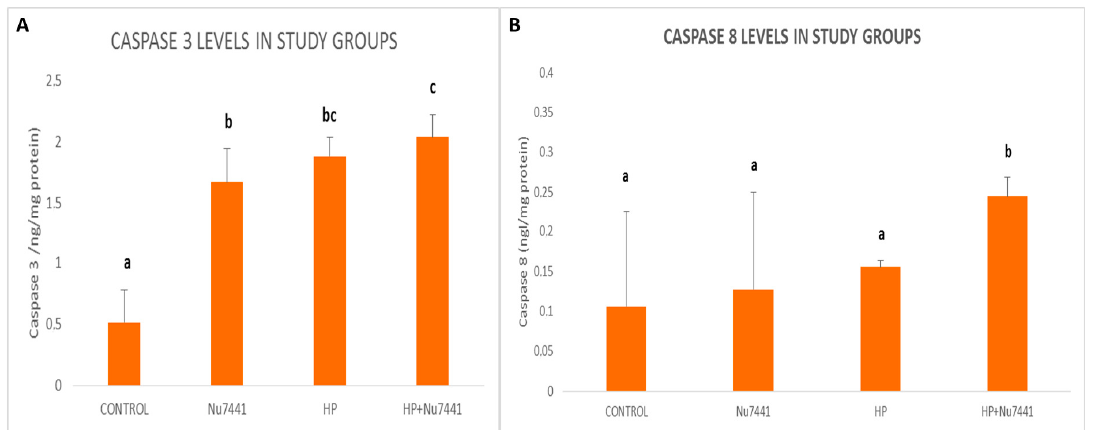
Figure 1. ( A ) Caspase-3 levels in the study groups. ( B ) Caspase-8 levels in the study groups. a,b,c Bars that do not have the same superscripts are significantly different than each other. t -test was used to compare the study groups. p < 0.05 is considered to be statistically